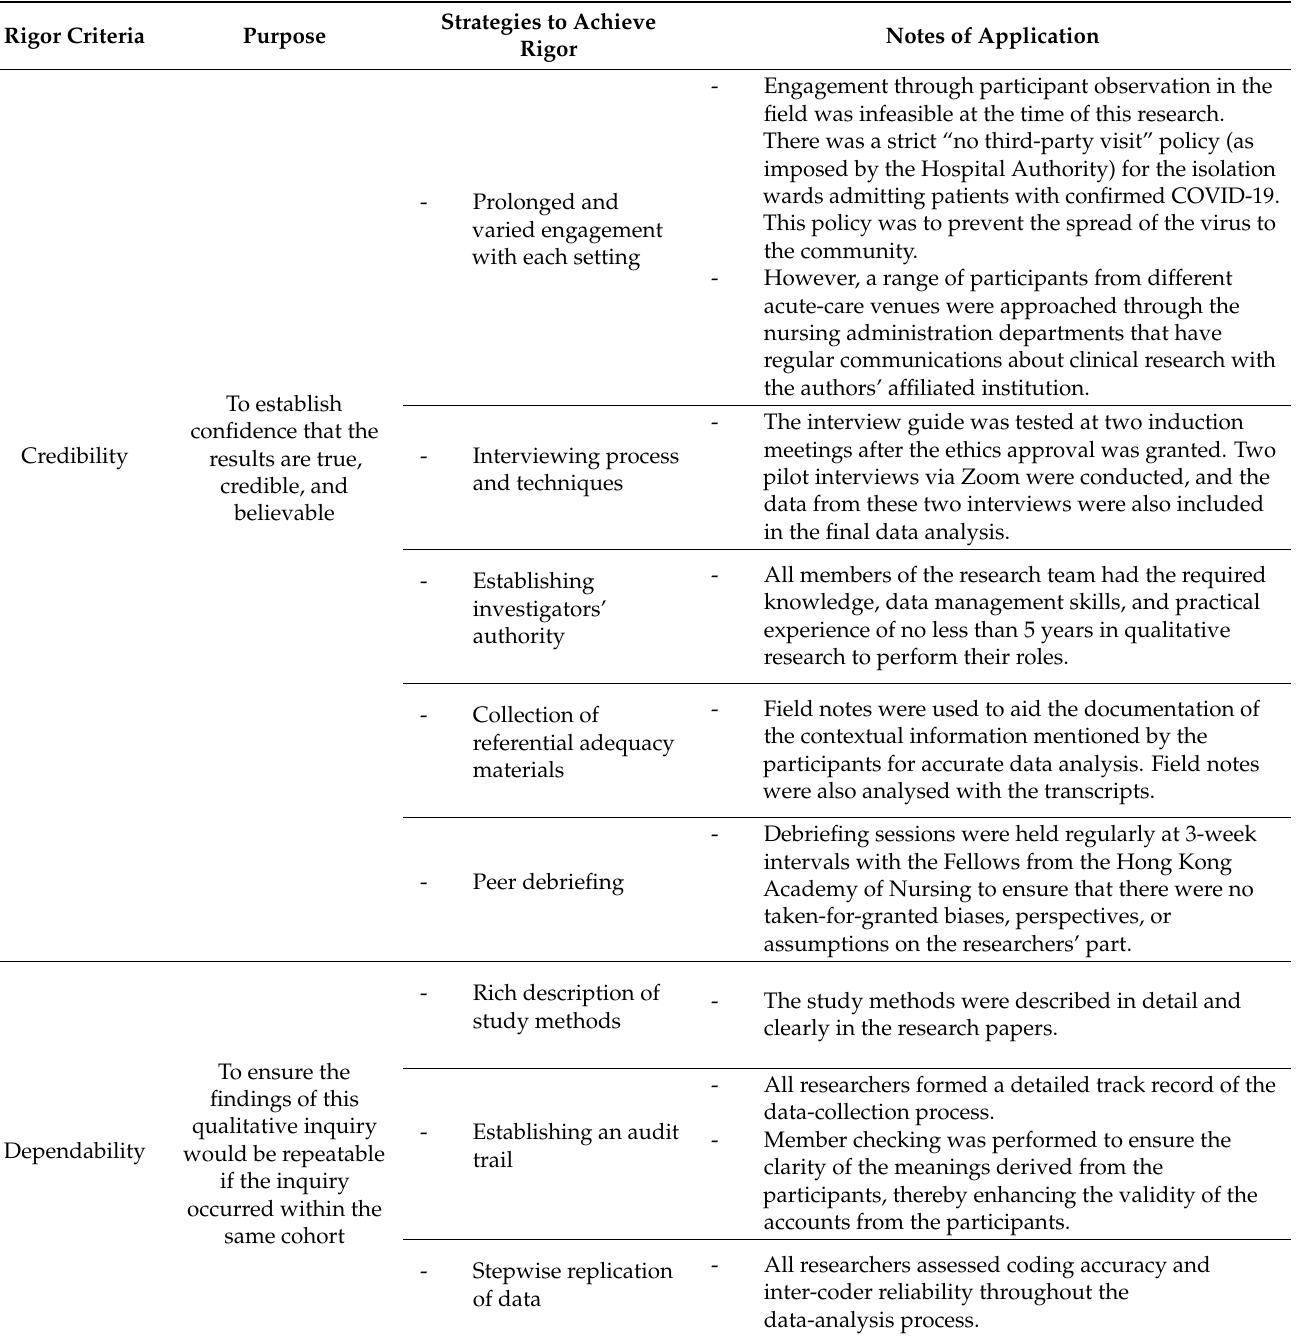
Table 3. Summary of strategies applied to achieve